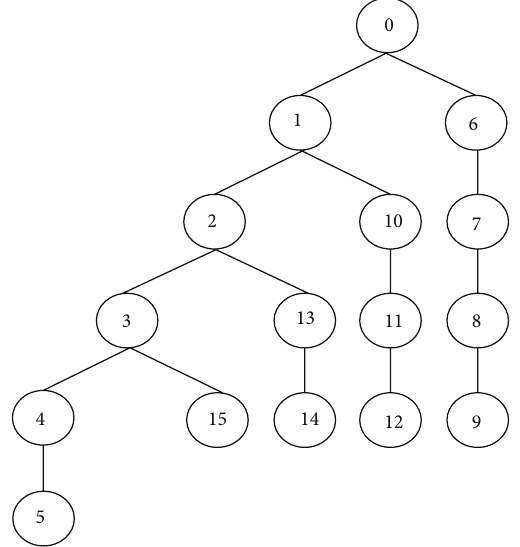
Figure 9: Tree organization for the proposed coverage algorithm.